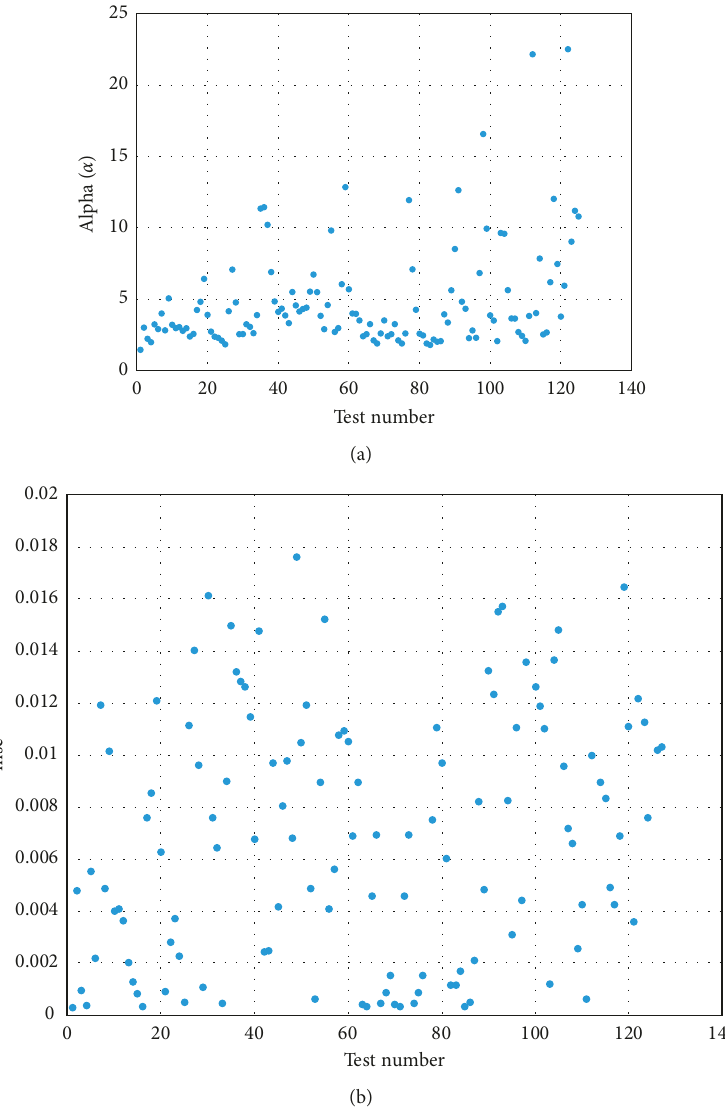
Figure 9: All (a) alpha ( α ) and (b) mse coefficients calculated by using the model proposed by Seed et al.